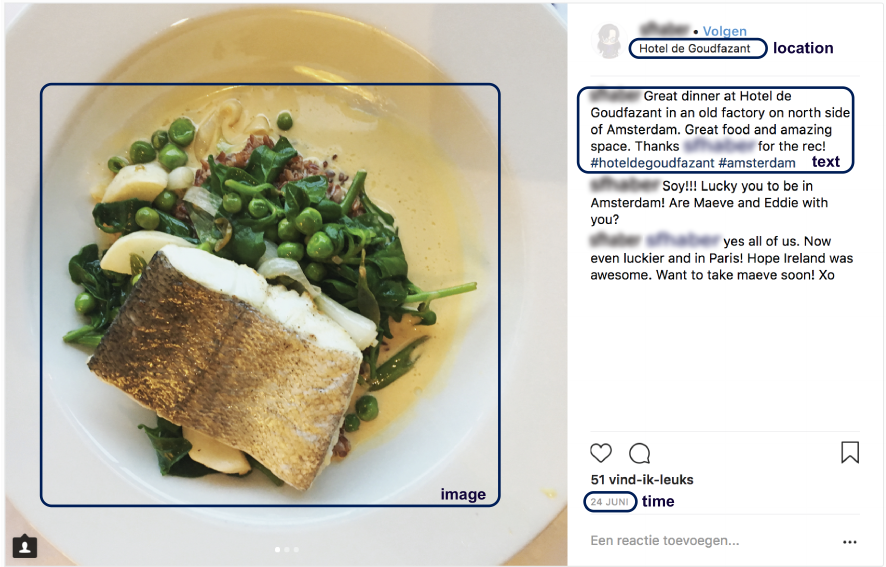
Figure 1. Example of social media post on